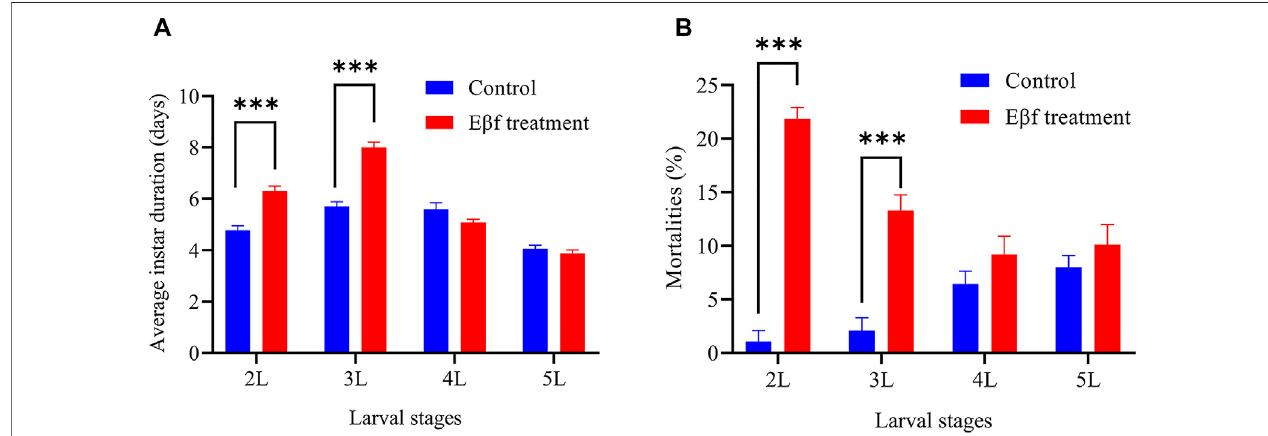
FIGURE1| Average instardurationsand mortalities in C.suppressalis larvae fedarti fi cialdiet containingE β f. (A) Average instar duration. (B) Mortalities. Values are means ± SEM of four replicates ( n = 24; N = 96). Asterisks indicate signi fi cant differences: * p < 0.05; ** p < 0.01; *** p < 0.001 (Mann-Whitney U test).